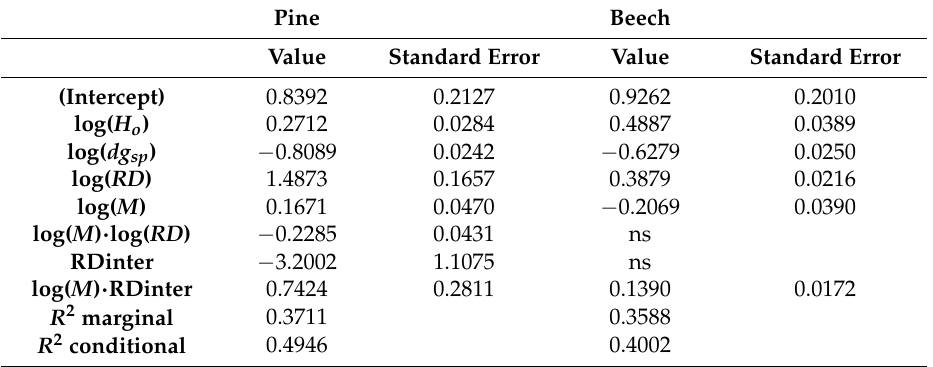
Table 2. Coefficient estimates and their standard errors for the Pine and Beech basal area growth efficiency models fitted using all national forest inventories (NFI) data.